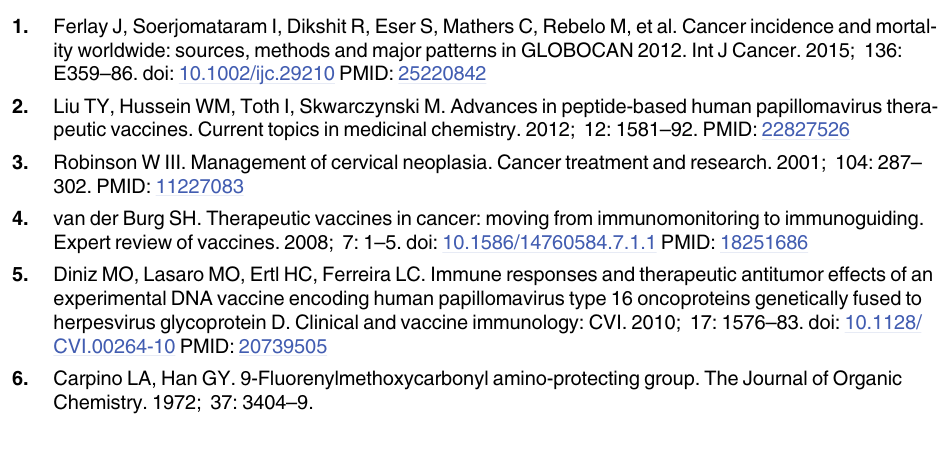
S1 Fig. Peptides identified by mass spectrometry. The aminoacid sequences of the E6E7 pro- tein. E6 (blue) and E7 (green) peptides are distinguished by color. Peptides identified by mass spectrometry are